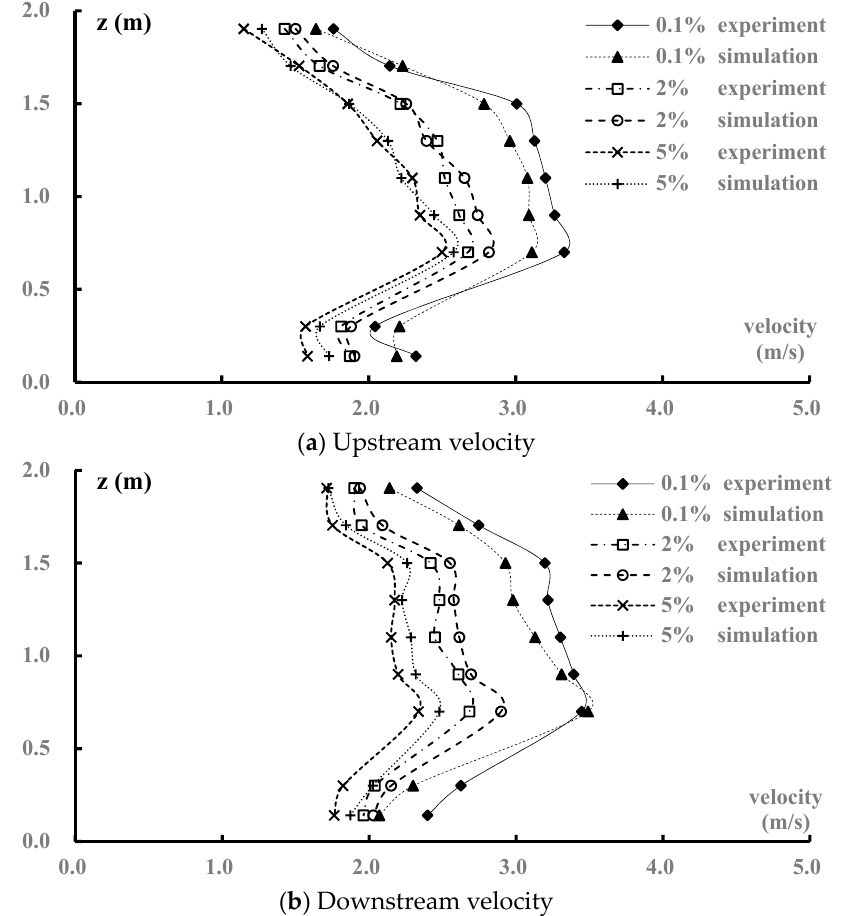
Figure 8. Velocity in the vortex drop shaft.